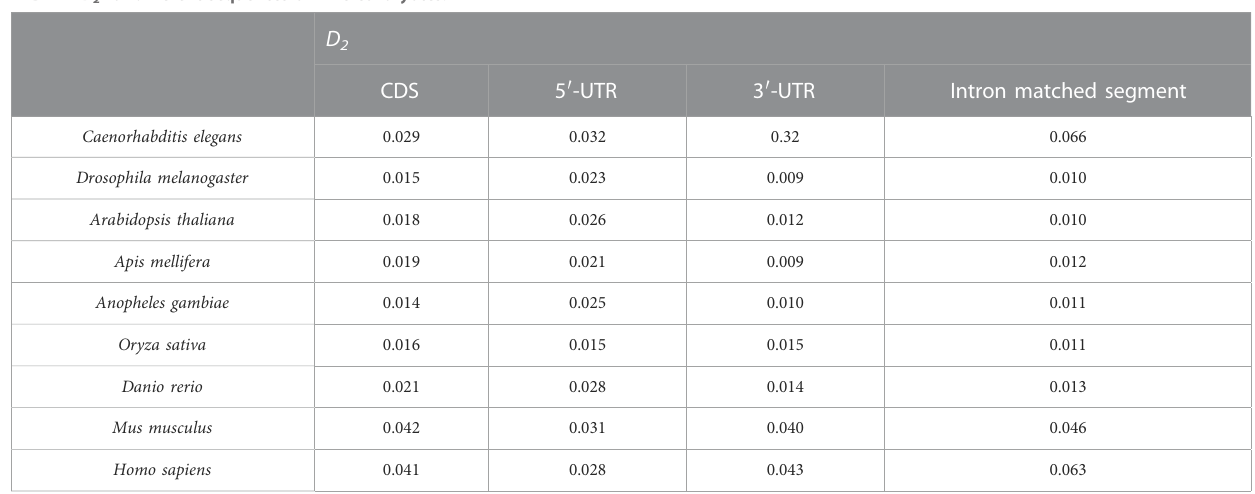
TABLE 2 D 2 for different sequences of nine eukaryotes.